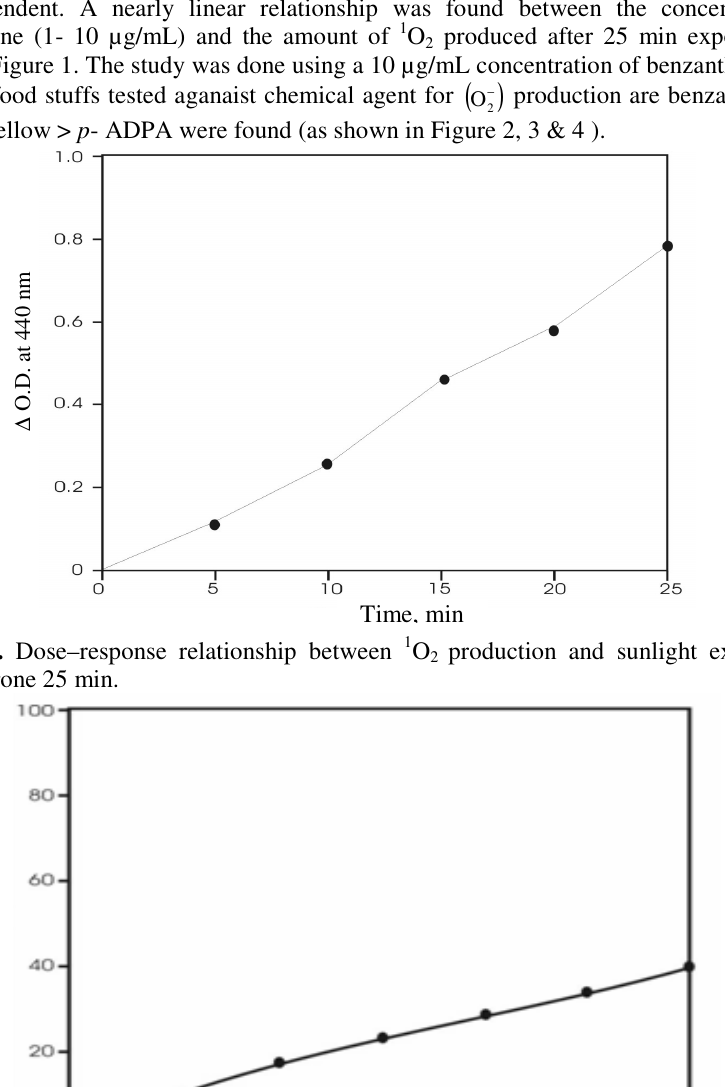
Figure 2. O - production by photosensitized reduction of NBT (1.6 x 10 -4 M in 0.01 2